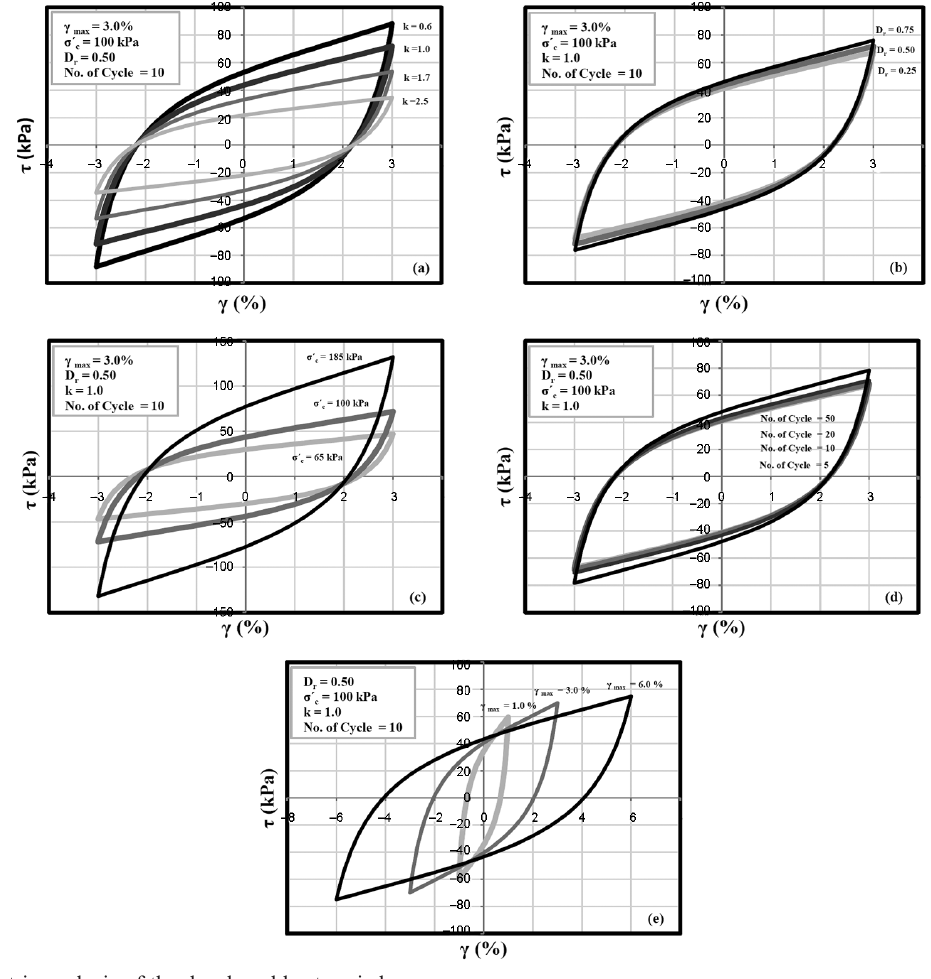
Fig. 12. Parametric analysis of the developed hysteresis loop